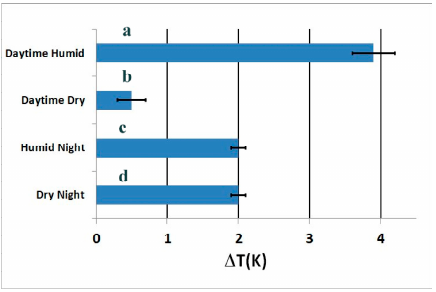
Figure 1. Key estimates were taken from Zhao et al.’s MODIS ∆ T data (see theirtable). The assessed values are (a) the daytime value of humid cities, (b) the daytime value in dry cities, (c,d) the nighttime value of humid cities, and (d) the nighttime value of dry cities. Error bars: 1 s.e.